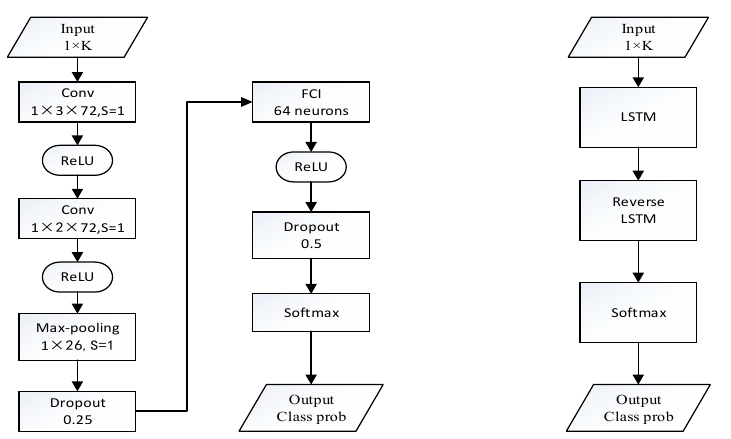
Figure 4. Network framework for different depth learning classifiers. Left: CNN Right: RNN-BLSTM.